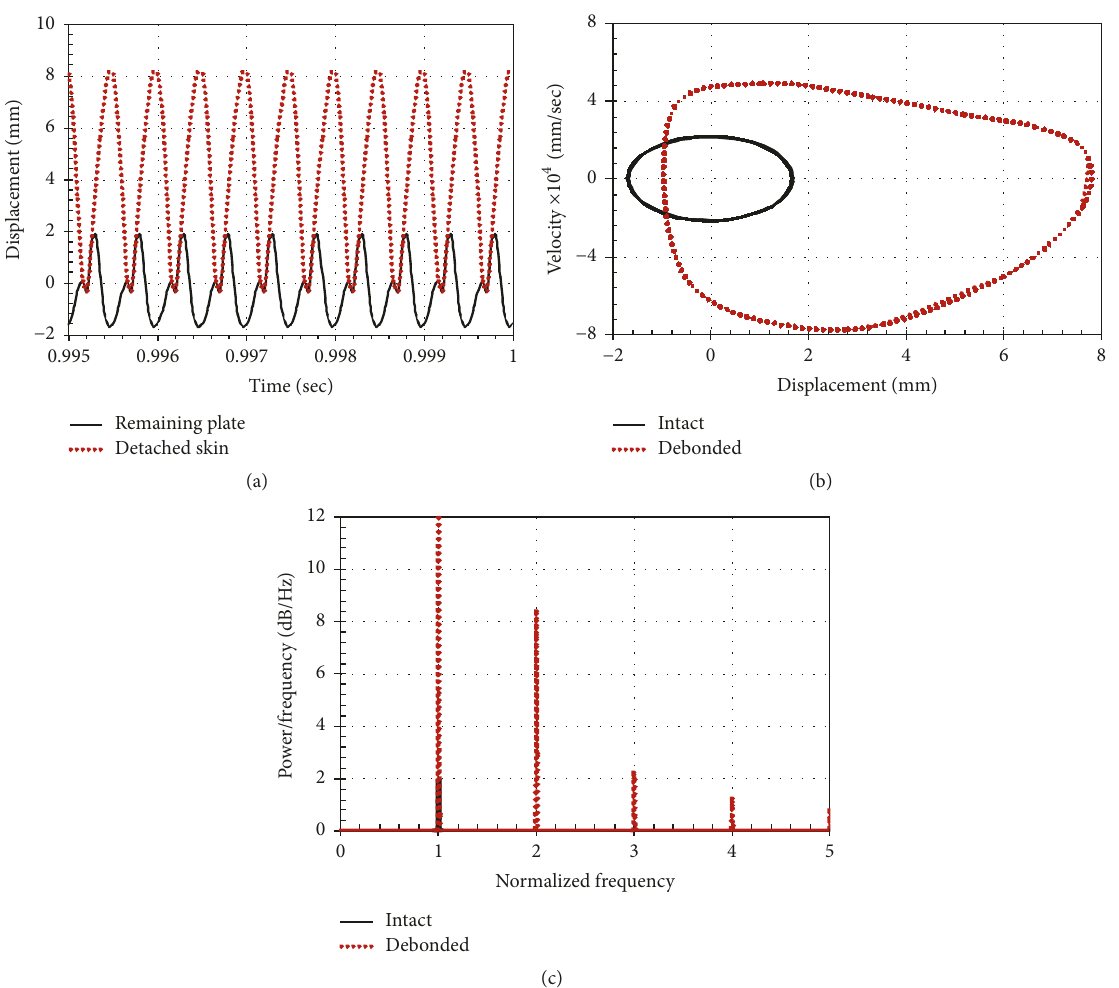
Figure 24: Steady-state dynamic response at 𝜂 = 2.0 (Ω = 2000 Hz ) : (a) displacement time histories at points N2 and N3; (b) phase portrait at point N1; and (c) frequency spectra of the displacement signals at point